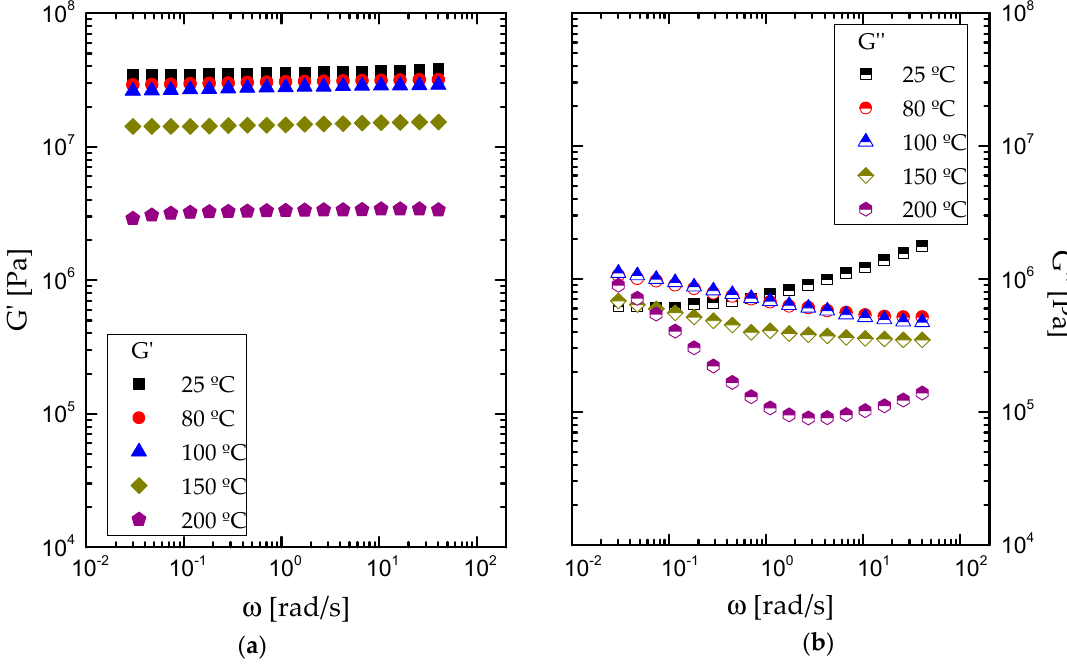
Figure 5. Evolution of ( a ) elastic, G ′ , and ( b ) viscous moduli, G ″ , with frequency, within the linear viscoelastic range, for formulations containing 50% CO castor oil at different temperatures.